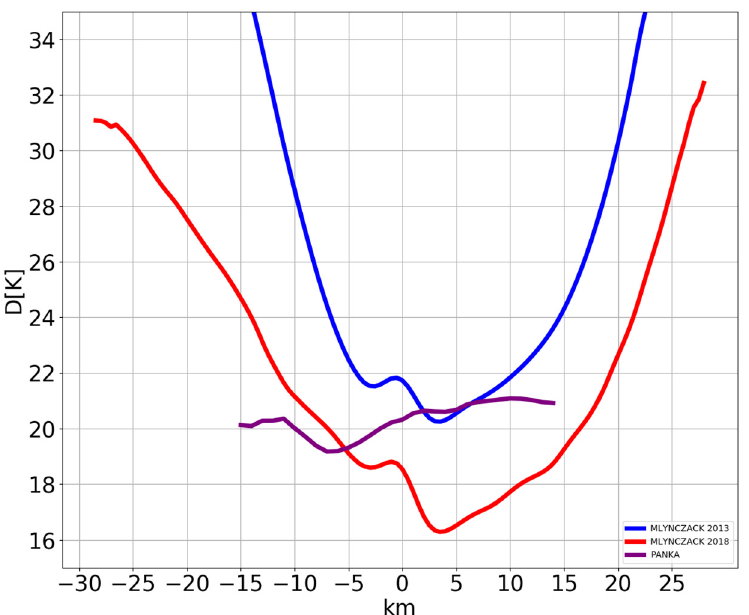
Figure 10. Graph of the error function dependence on airglow profile height shift. Blue is based on data calculated using [17], red is based on data calculated using [24], and magenta is based on data calculated using [25].